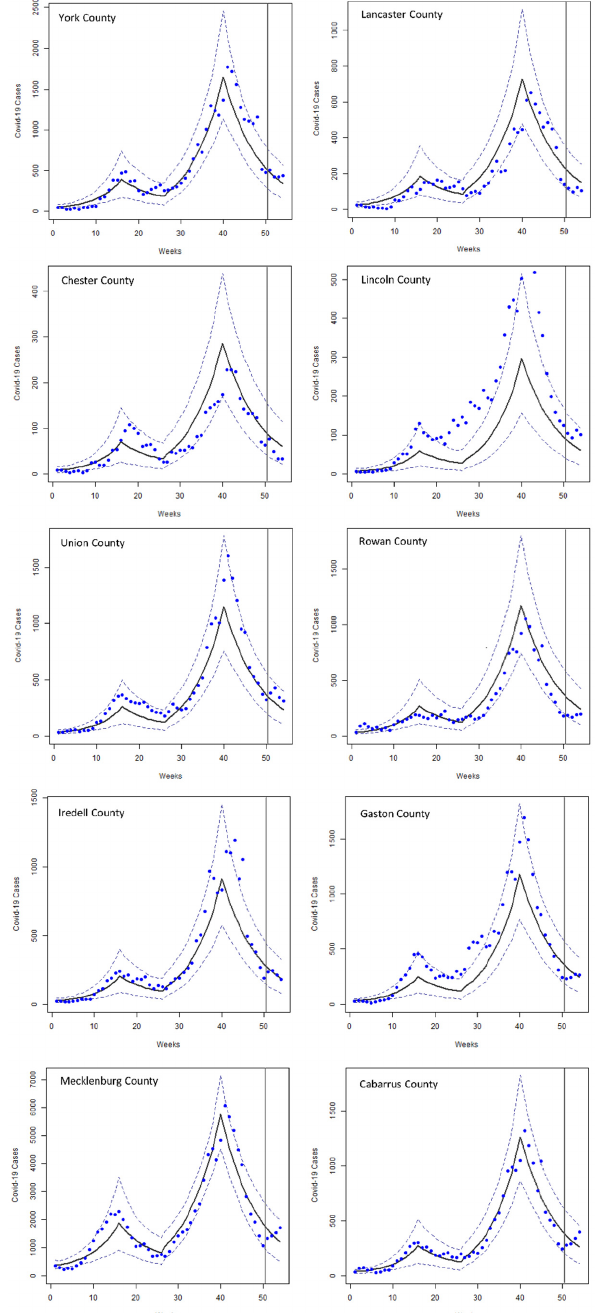
Figure 2. Reported historical (blue dots) COVID-19 cases and cases simulated with model 2 (black line) in 10 counties of the study area, including the last 4 weeks not used for model fitting. The 5% confidence interval is shown with dashed lines. The last 4 weeks to the right of the gray vertical lines show the forecasted number of